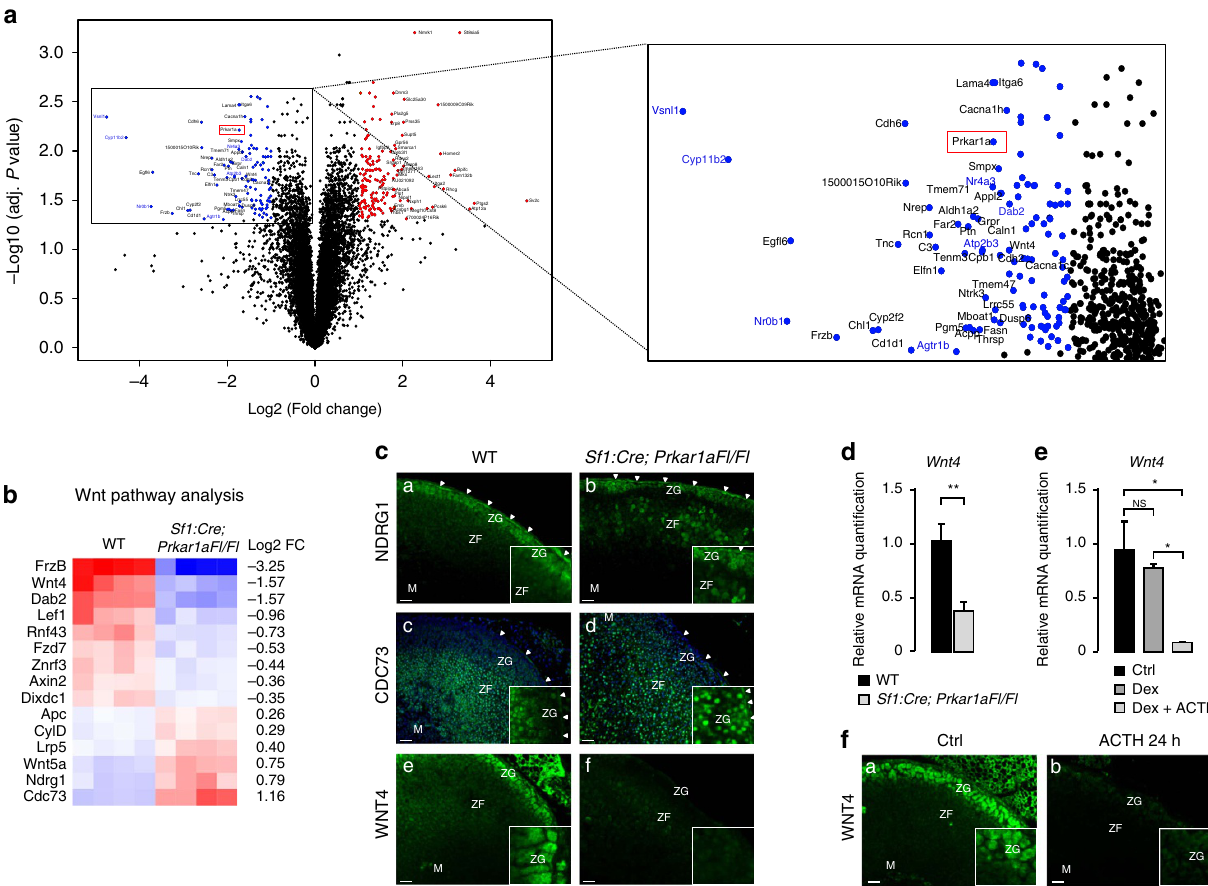
Figure 3 | WNT4 is downregulated by PKA signalling activation. ( a ) Constitutive activation of PKA signalling inhibits ZG markers expression. Volcano plot shows differential gene expression in adrenals from four Sf1:Cre;Prakr1aFl/Fl mice compared with four wild-type littermates. A number of ZG differentiation markers (gene symbols in blue) are among the most significantly downregulated genes. As expected, Prkar1a expression (red rectangle) is significantly decreased in knockouts. ( b ) Constitutive activation of PKA signalling modulates expression of WNT pathway target genes and regulators. Colour-coded heatmap shows expression of the 15 genes that were significantly deregulated (adjusted P value o 0.05). ( c ) Expression of NDRG1, CDC73 and WNT4 in mouse adrenals. Expression of the two potential WNTsignalling repressors NDRG1 and CDC73 and of the WNT ligand WNT4 was analysed by immunohistochemistry in wild-type ( n ¼ 4; a,c,e) and Sf1:Cre;Prkar1aFl/Fl adrenals ( n ¼ 4; b,d,f). Hoechst nuclear staining in c and d highlights the lack of Cdc73 expression in wild-type outer cortex. Insets show high magnification pictures of ZG. Arrowheads show adrenal capsule. ( d ) Constitutive activation of PKA signalling inhibits Wnt4 expression. Wnt4 expression levels were analysed by RT–qPCR on mRNAs extracted from wild-type and Sf1:Cre;Prkar1aFl/Fl adrenals. Bars represent the mean expression in six animals per group ± s.e.m. Statistical analyses were performed by Student’s t -test. ( e ) ACTH stimulation represses Wnt4 expression. Wnt4 expression levels were analysed by RT–qPCR on mRNAs extracted from adrenals of wild-type mice treated with vehicle, dexamethasone or dexamethasone and ACTH as in Fig. 1a. Bars represent the mean expression in four animals per group ± s.e.m. Statistical analyses were performed by one-way ANOVA followed by Tukey’s post hoc test. ( f ) ACTH induces a rapid decrease in WNT4 protein accumulation. WNT4 expression was analysed by immunohistochemistry in the adrenal cortex of wild-type mice ( n ¼ 4), 24h after a single ACTH (Synacthene retard)